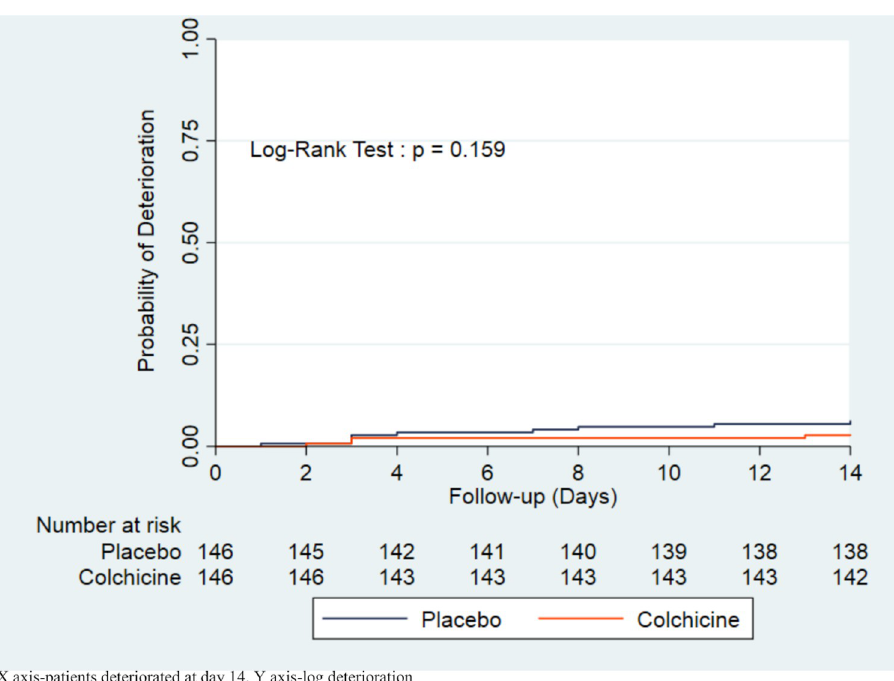
Fig 2. Kaplan-meier survival curves based on the primary clinical endpoint on day 14 using the log rank test.